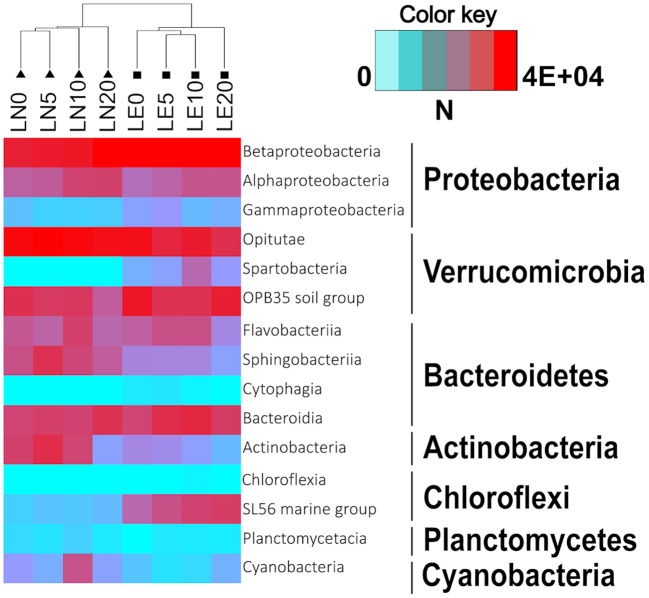
Heatmap showing the abundance of classes of the seven most representative phyla in the samples. Dendrogram shows Bray-Curtis similarities between samples.